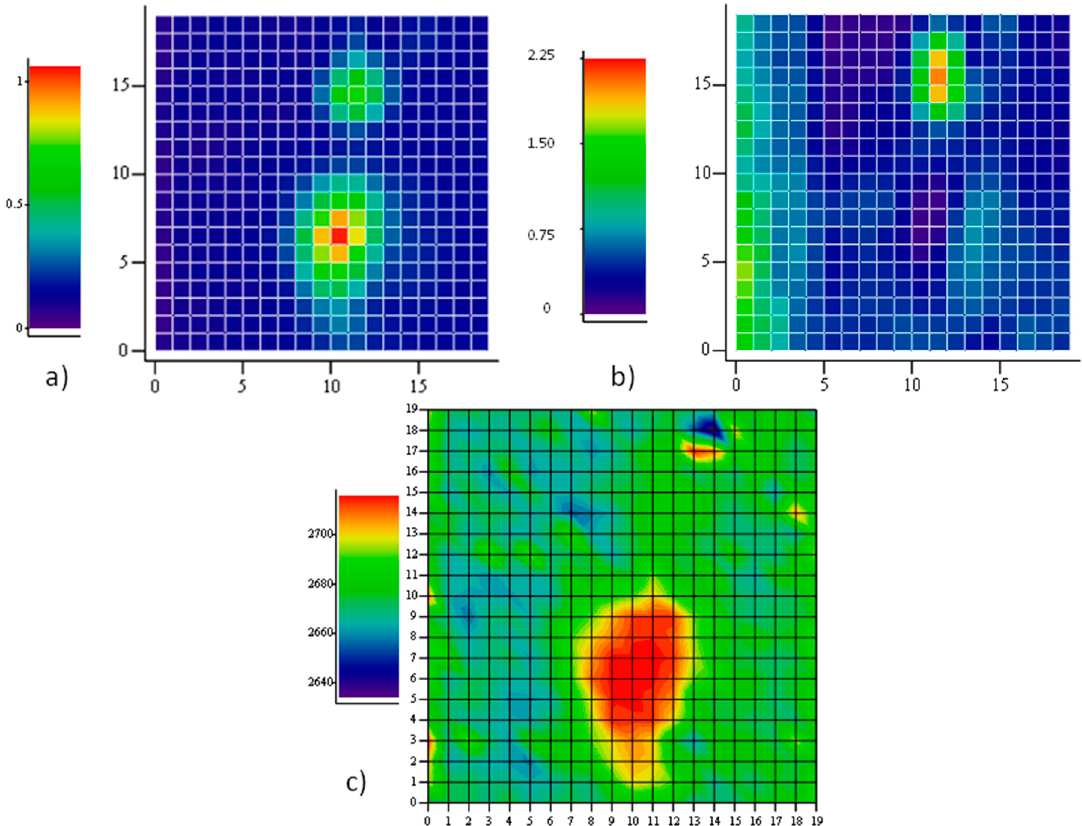
Figure 4. Raman map on a 20 μ m × 20 μ m area of graphene grown on Co: ( a ) the intensity of the Raman emission of graphene at ~2690 cm − 1 , which allows to localize two holes in the underlying metal. The Raman intensity is normalized to 1 at maximum; ( b ) the ratio between the intensity of the defect peak D and the G peak; and ( c ) the map of the centroid of the 2D feature, indicating a large shift towards higher energies in correspondence of the larger hole in Co, whose major axis approaches 10 μ m.